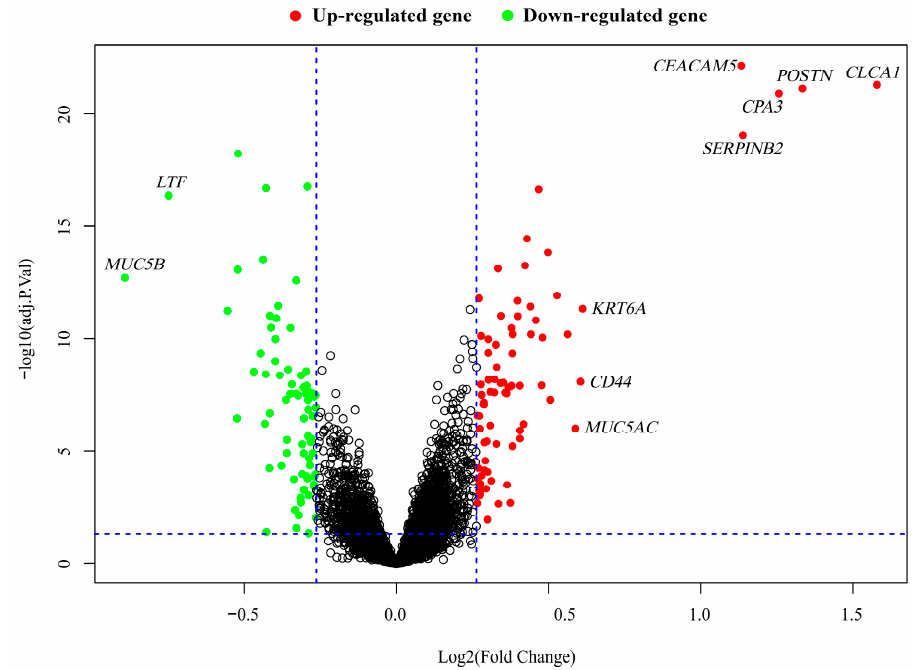
Figure 3. Volcano plot for 153 differentially expressed genes between asthmatics and healthy controls. The up- and down-regulated genes are marked in red and green, respectively. Genes with fold change more than 1.5-fold are labeled by gene symbols.